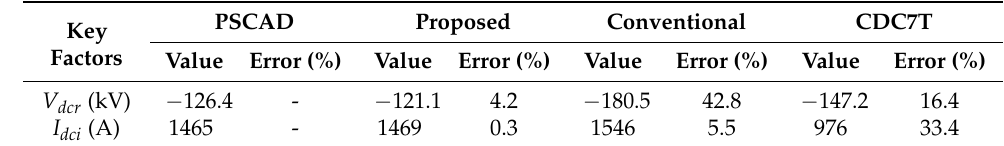
Table 8. Summary of the maximum DC voltages and currents at the inverter for the three-phase line-to-ground fault.